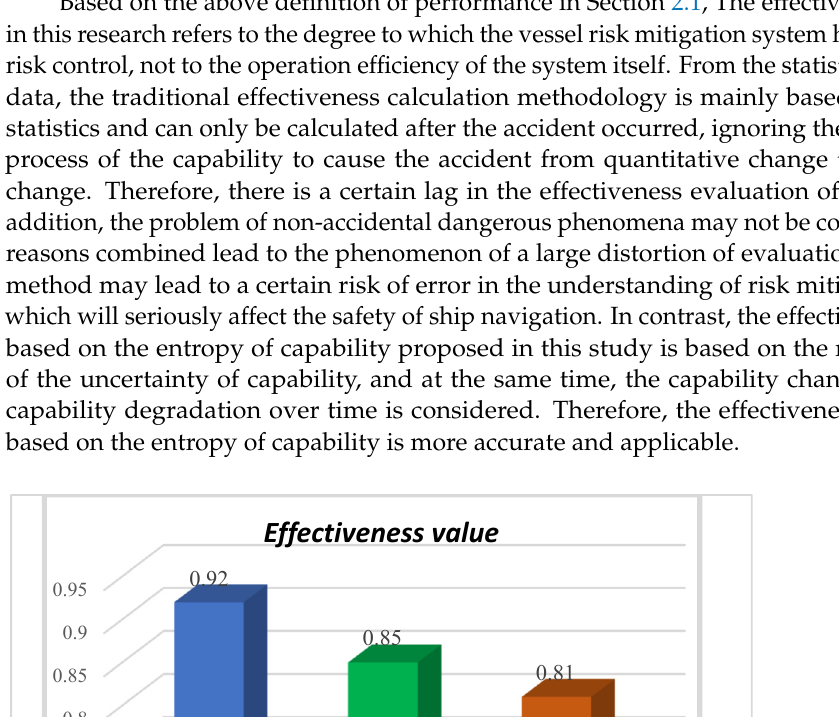
Table 15. Effectiveness value based on the entropy of capability construction.